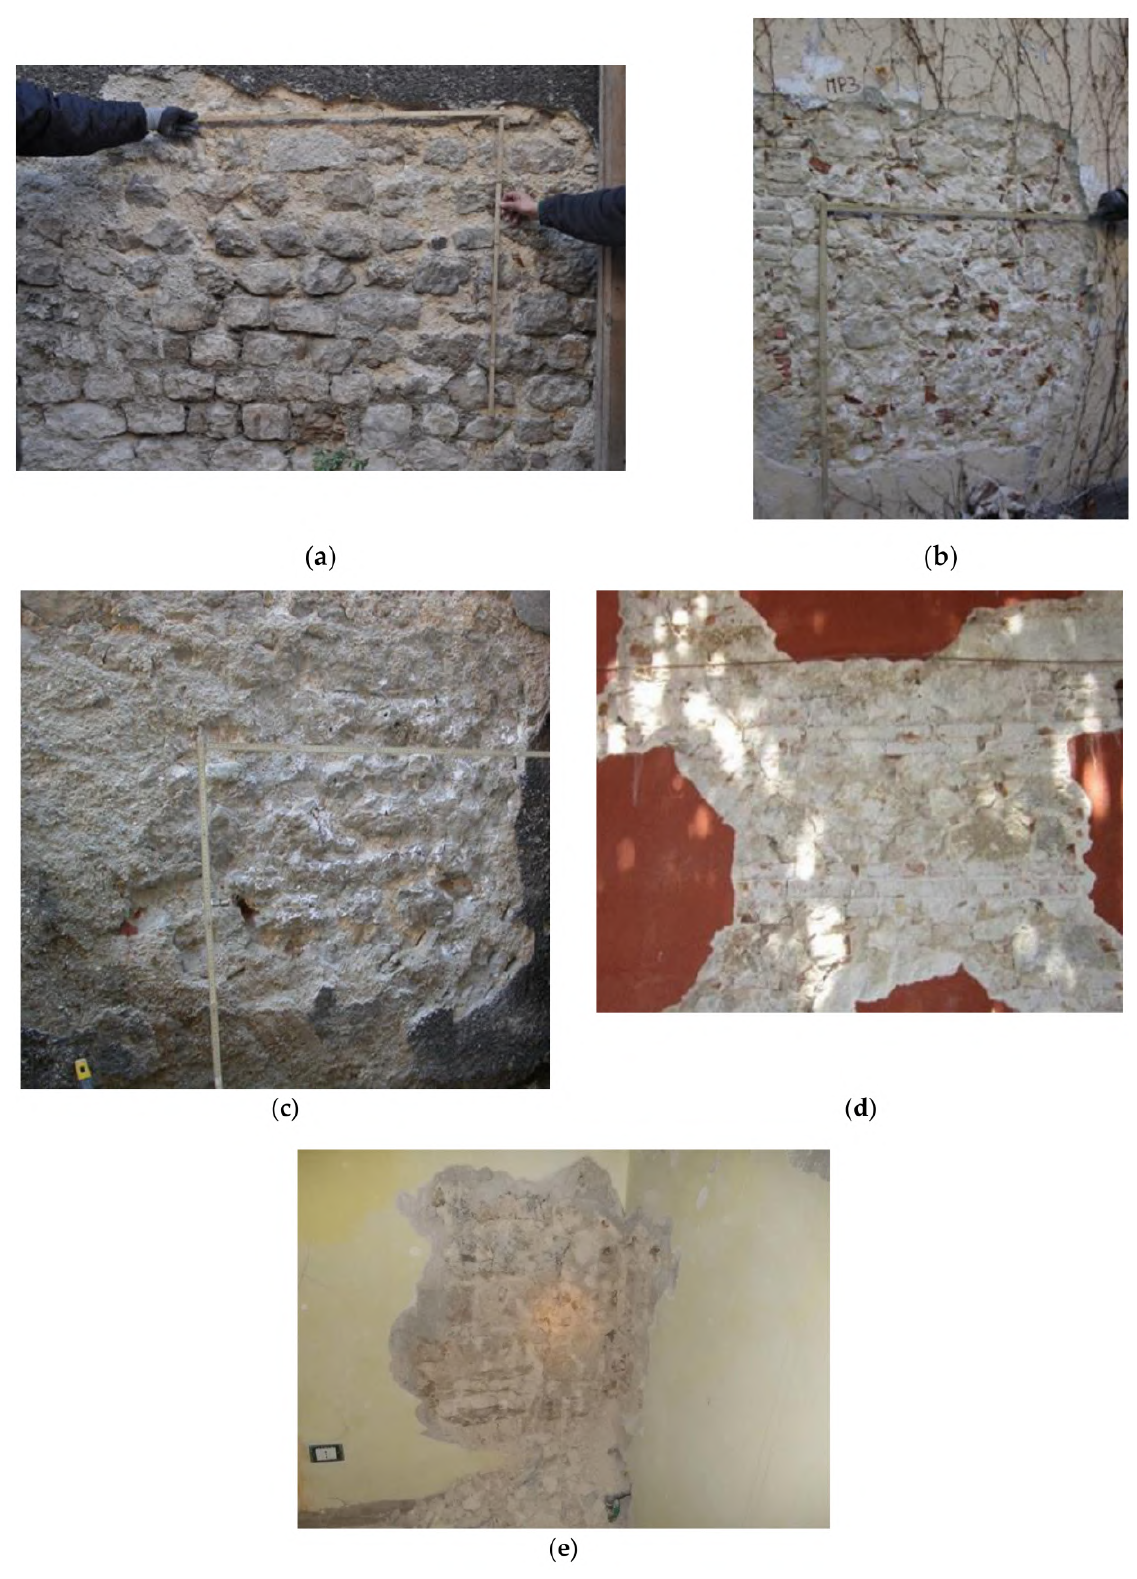
Figure 8. Views of the typical masonry typologies detected in L’Aquila: ( a ) VS1; ( b ) VS2; ( c ) VS3; ( d ) VS4; ( e )